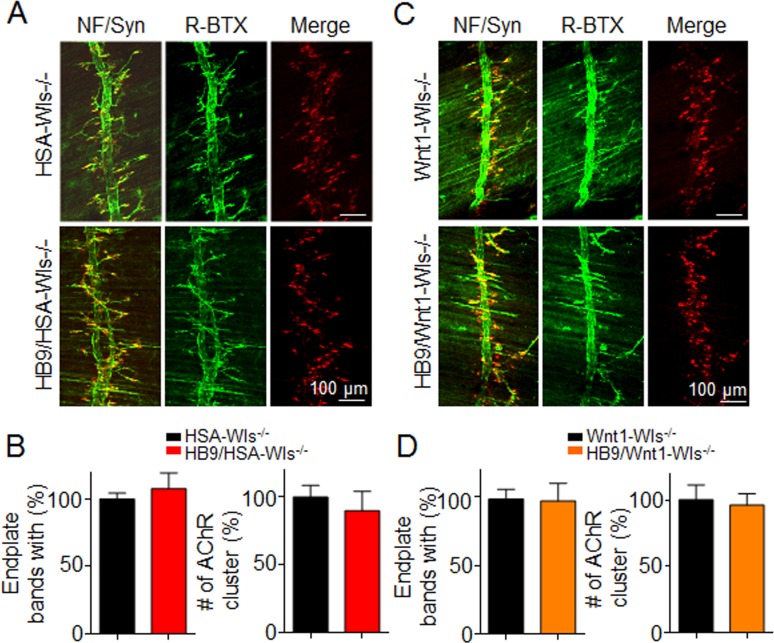
Comparable NMJ formation between HSA-Wls-/- and HB9/HSA-Wls-/-, Wnt1-Wls-/- and HB9/Wnt1-Wls-/- mice.(A) Immunostaining of NMJs in diaphragms of HSA-Wls-/- and HB9/HSA-Wls-/- E18.5 embryos with anti-NF/Syn (Green). R-BTX stains postsynaptic AChR (Red). Scale bar, 100 μm. (B) The statistics of endplate width and AChR cluster number in A. n = 3 mice per group; Unpaired t-test. p>0.05. (C) Immunostaining of NMJs in diaphragms of Wnt1-Wls-/- and HB9/Wnt1-Wls-/- E18.5 embryos with anti-NF/Syn (Green). R-BTX stains postsynaptic AChR (Red). Scale bar, 100 μm. (D) The statistics of endplate width and AChR cluster number in C. n = 3 mice per group; Unpaired t-test. p>0.05.